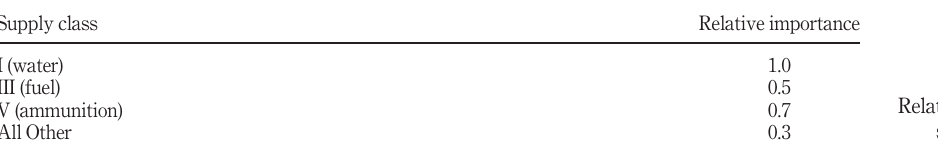
Table 2. Relative priority